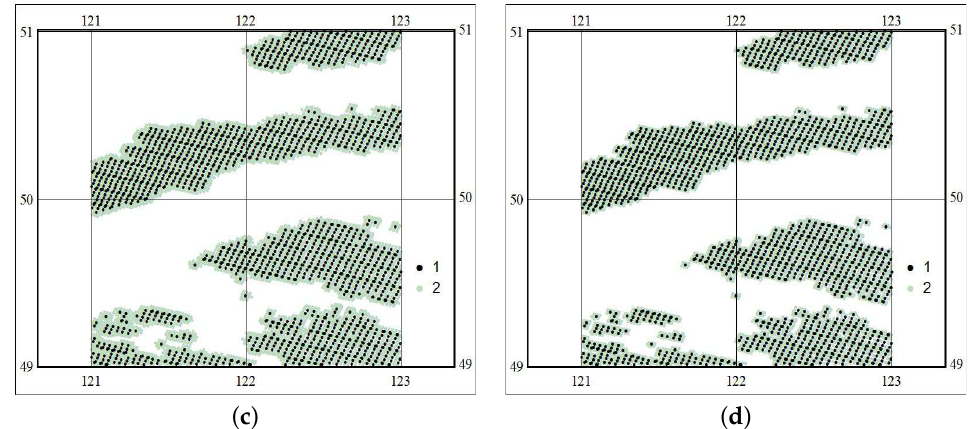
Figure 6. Mask illustrating the adjacency effect on the reconstructed reflectance of cloudless areas: ( a ) fragment 1, calculation; ( b ) fragment 1, interpolation; ( c ) fragment 2, calculation; and ( d ) fragment 2, interpolation. Designations: 1 is for pixels shadowed by clouds and 2 is for cloudless pixels with significant ∆ r surf values caused by the cloud adjacency